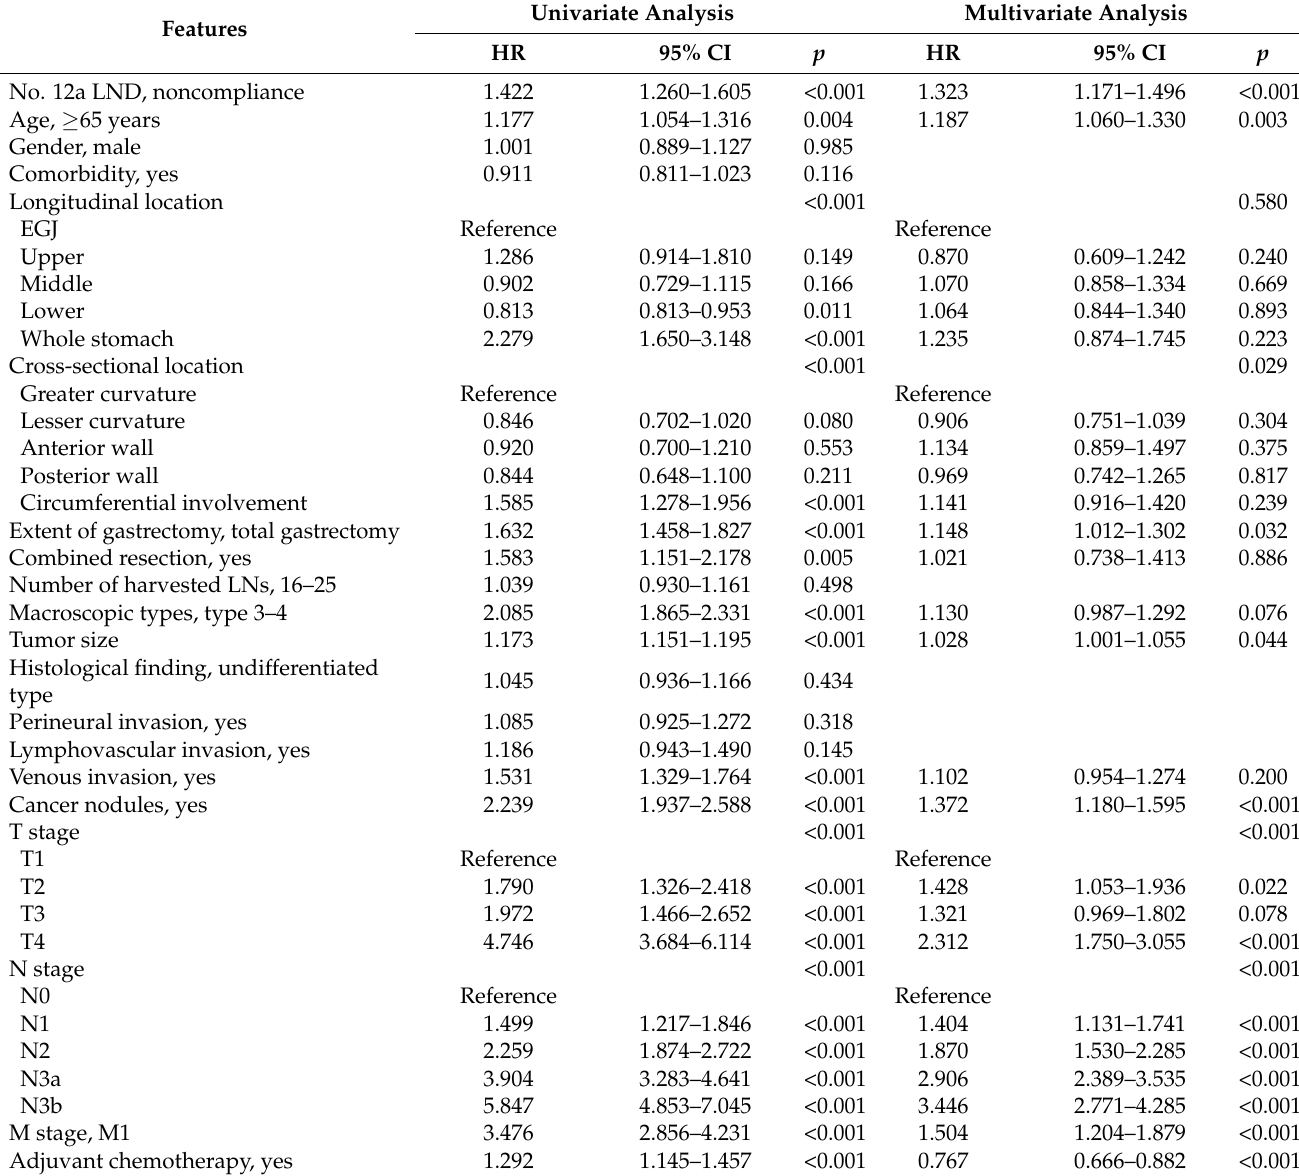
Table 4. Univariate and multivariate survival analysis in this study by Cox proportion hazard model before